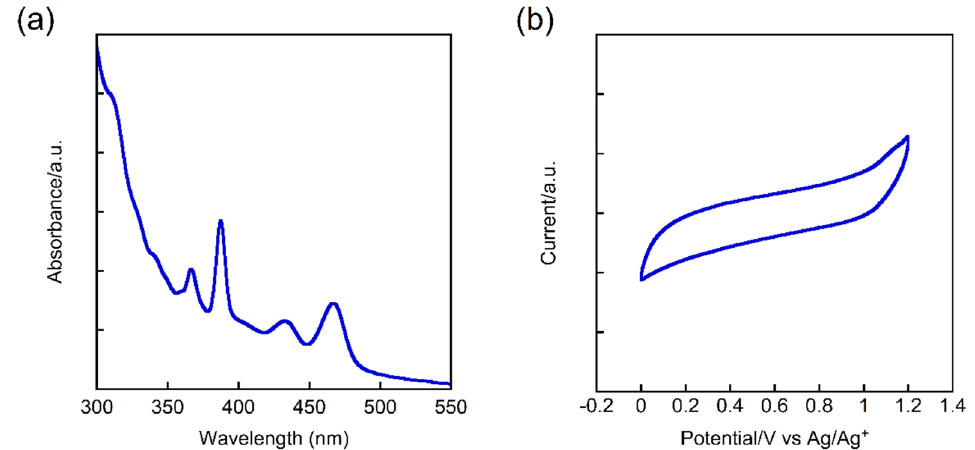
Figure 2. ( a ) UV-Vis absorption spectrum in thin film and ( b ) cyclic voltammogram in CH 2 Cl 2 solution of C6-DNADT.